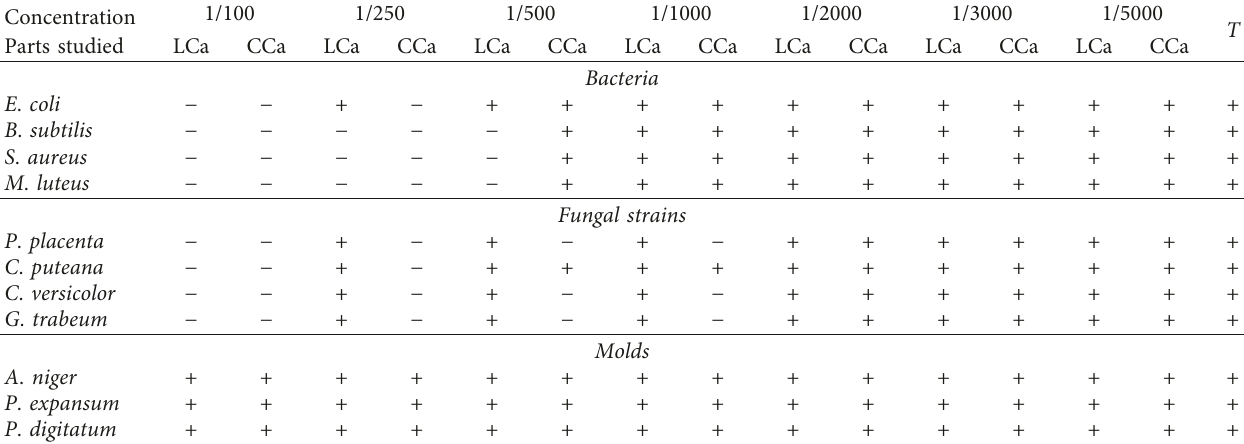
Table 2: Antibacterial and antifungal activity of essential oil extracted from the leaves and cones of C . arizonica .